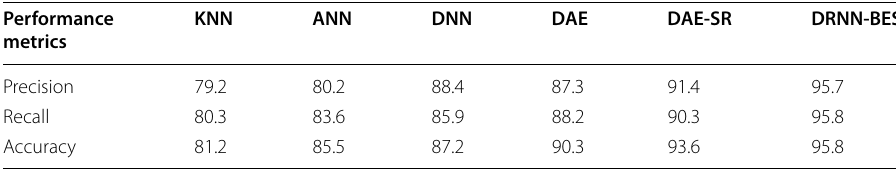
Table 7 Jaro–Winkler distance based performance comparison